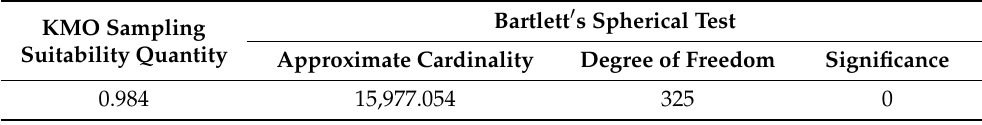
Table 6. KMO and Bartlett’s test.